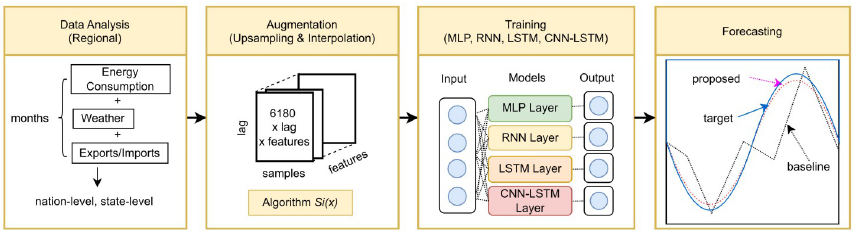
Fig 2. Visualization of the proposed